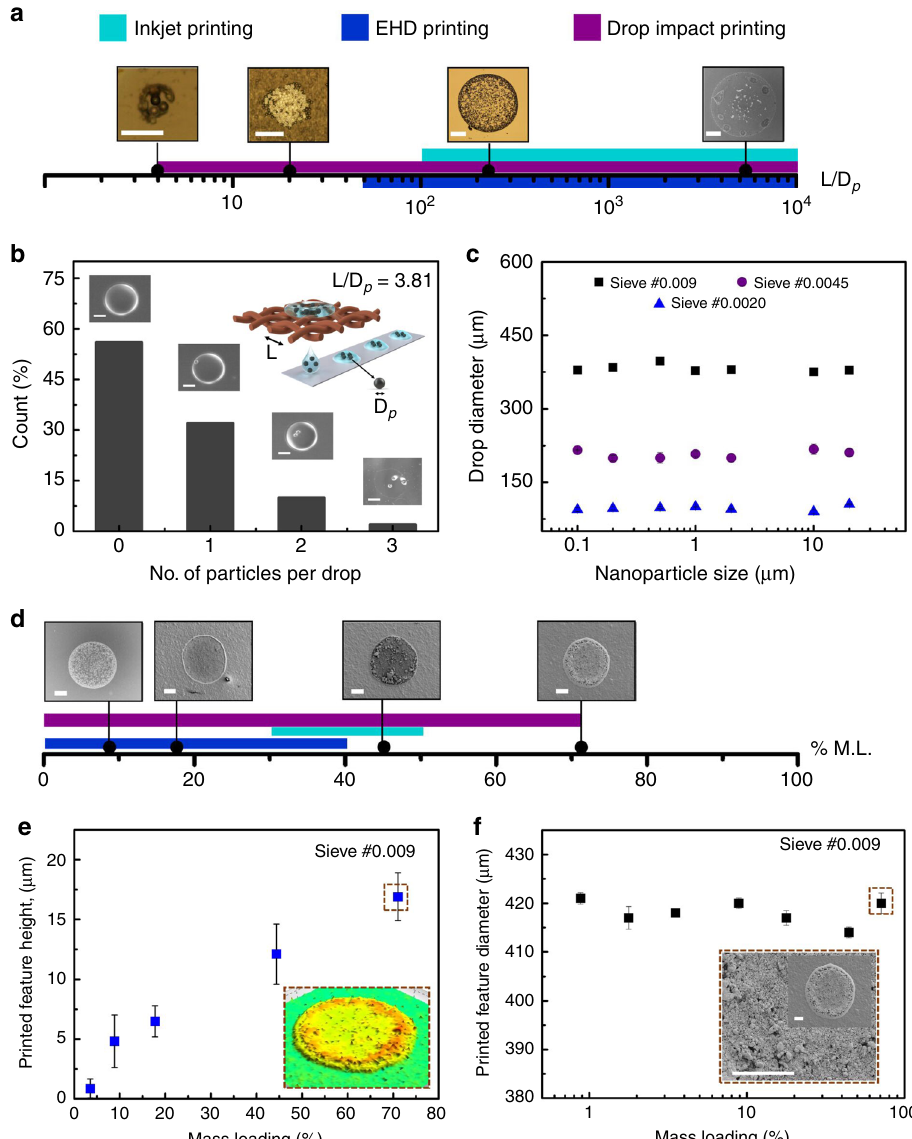
Fig. 3 Clogging-free printing with a large particle size and higher mass loading printing. The clogging-free printing was demonstrated based on the ability to print a large particle size and high mass loading suspensions. a The larger particle size printing ability was shown in a linear L/D p chart with the inset showing a different printed particle size for different L/D p (scale bar: 100 µ m) ratios. L/D p can be as low as 3.81 for drop-impact printing, which is signi fi cantly smaller as compared to inkjet and electrohydrodynamic (EHD) printing. b The percent count to print a single and multiple beads in a drop is demonstrated. The probability of single- bead capturing in a single drop (80- µ m diameter) was found to be 32%. The inset shows the number of beads in a single drop (scale bar: 100 µ m). c Further, the printed droplet diameter with varying particle size is shown. The droplet diameter was independent of different particle-size suspensions. d The linear chart shows that as high as 71% mass loading suspension solution printing is possible using drop-impact printing as compared to inkjet and EHD printing. The inset shows the scanning electron microscopy (SEM) image of a printed droplet for different mass loading (scale bar: 100 µ m). e The printed feature height is shown with varying mass loading (print substrate — glass). The inset shows the printed droplet with 71% mass loading having a base diameter of 990 µ m (sieve used — #0.009). f Further, the printed droplet diameter was plotted with varying mass loading (inset image scale bar: 100 µ m). The printed drop size was found to be independent with an increase in mass loading. Insets in both fi gures ( e ) and ( f ) show a higher mass loading printed